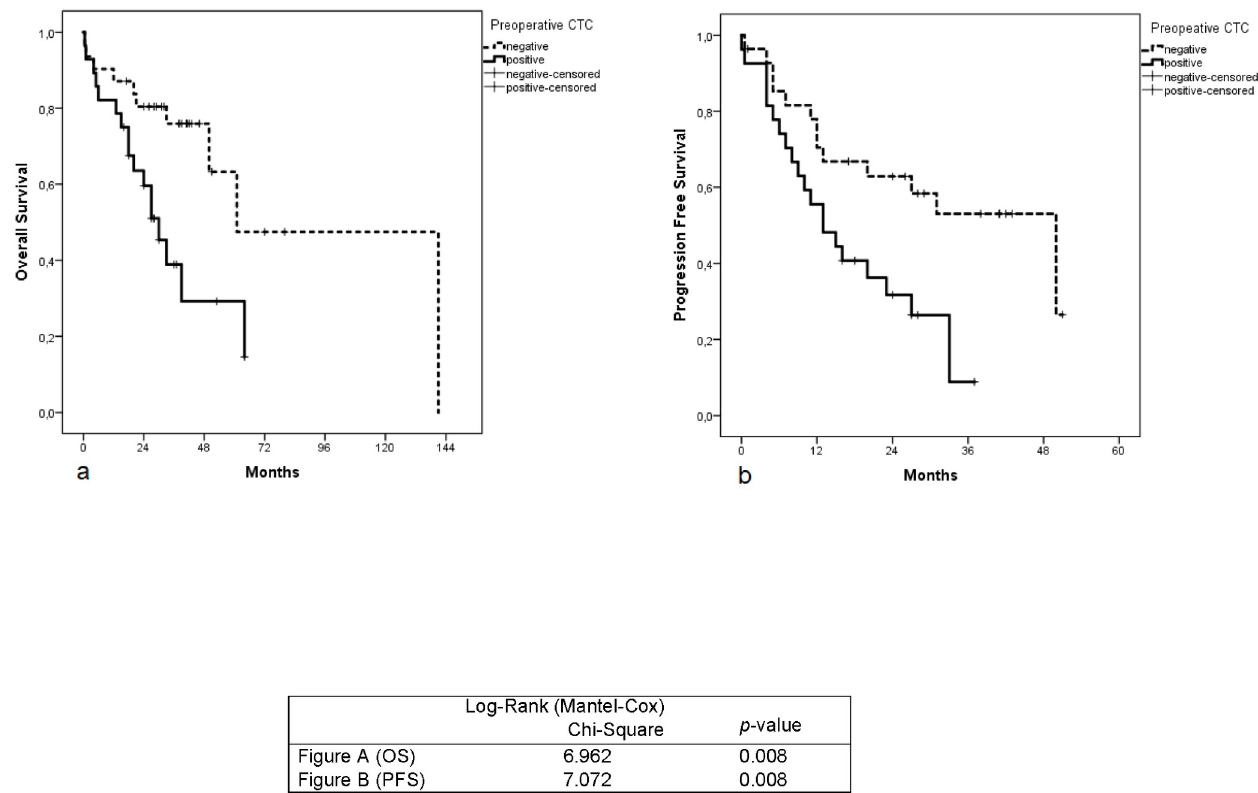
Fig 2. Kaplan-Meier survival analysis for overall survival and progression-free survival according to the preoperative CTCs. (a): Overall survival in patients with CRC, positive vs. negative preoperative CTCs. (b): Progression-free survival in patients with CRC, positive vs. negative preoperative CTCs. P - value Indicates significance according to Log-Rank (Mantel-Cox) test when CTC-negative patients are compared with CTC-positive patients preoperatively.